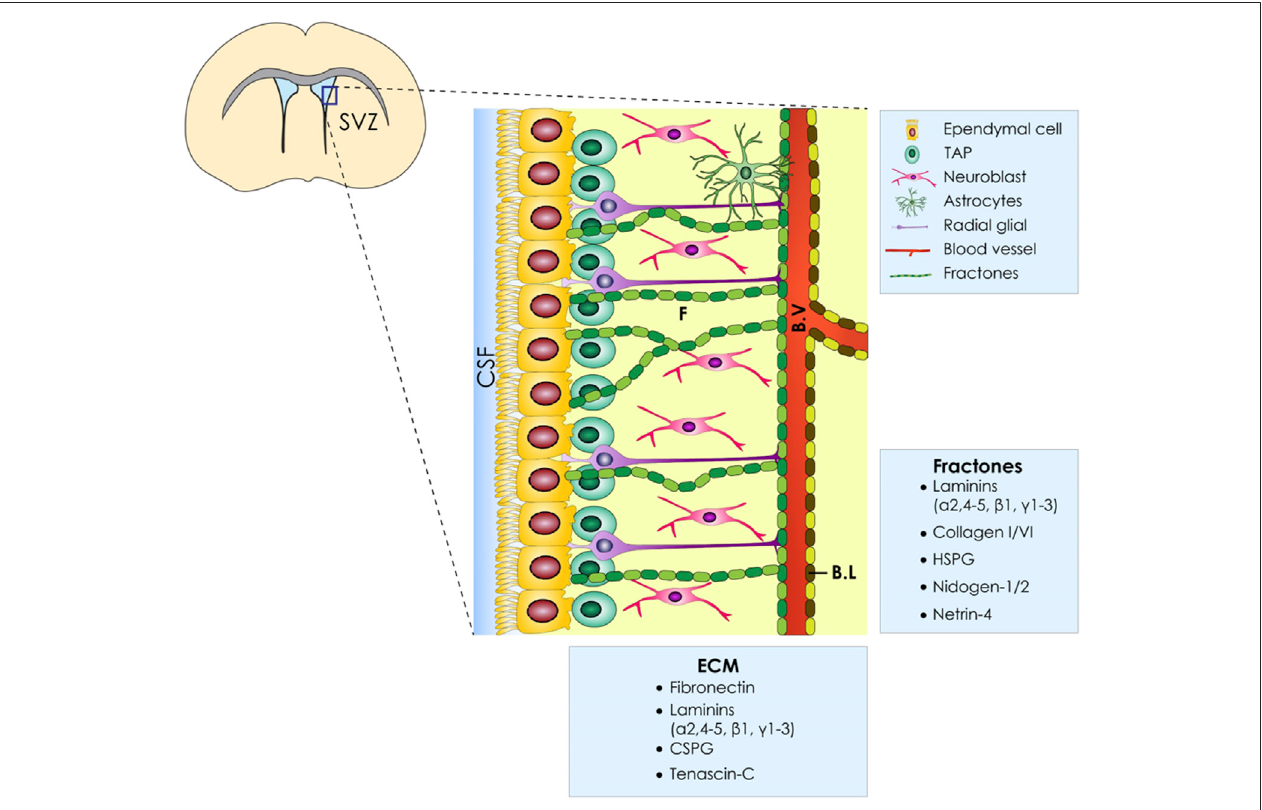
FIGURE 1 | ECM of the ventricular – subventricular zone (V-SVZ) of the stem cell niche. Diagrammatic representation of the neural stem cell niche cellular constituents (E, ependymal Cells; NSC, neural stem cells; NB, neuroblasts; TAPs, transit amplifying progenitors; BV, blood vessels; ECM, extracellular matrix; BL, basal lamina). Moreover, the ECM of the SVZ has several components named fractones (F) which are in proximity with all cell